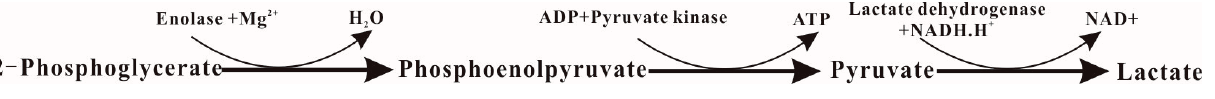
Figure 8. The reactions of transformation of NADH.H + to NAD + associate with a-enolase. The enzymatic reactions were performed at room temperature in 100 mM HEPES buffer (pH 7.0, containing 3.3 mM MgSO 4 , 0.2 mM NADH, 1.0 mM 2-PGE, 1.2 mM ADP, 10.3 IU of